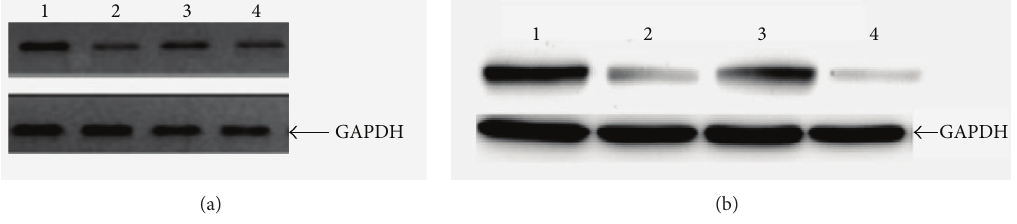
Figure 3: Western blot showing expression of wild-type and mutated recombinant TPO. (a) Lane 1, wild-type recombinant TPO. Lanes 2–4, recombinant TPO containing (2-Glu 641 Lys, 3-Asp 668 Asn, and 4-Thr 725 Pro) changes. In (b) Western blot showing expression of wild-type and mutated recombinant TPO. Lane 1, wild-type recombinant TPO. Lanes 2–4, recombinant TPO containing (2-Asp 620 Asn, 3-Ser 398 Thr, and 4-Ala 373 Ser)